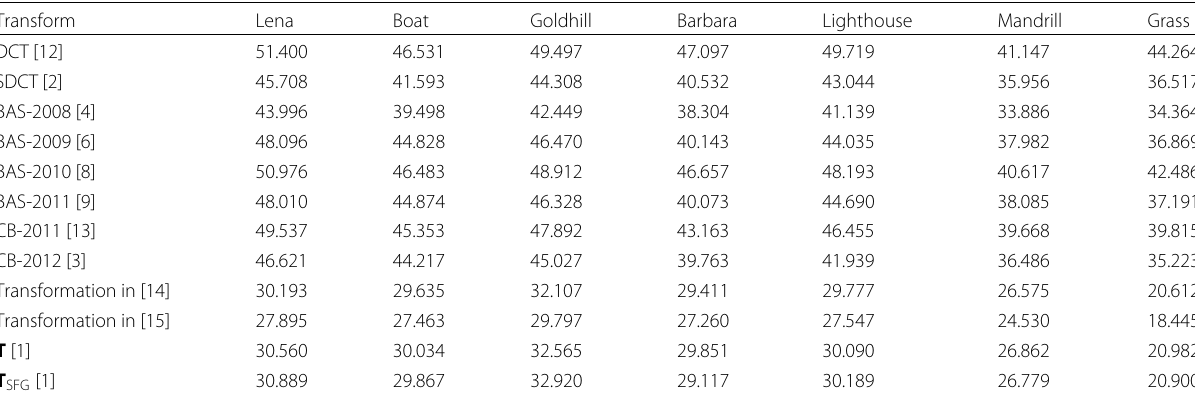
Table 2 PSNR of reconstructed images ( r = 6 w 0) Transform